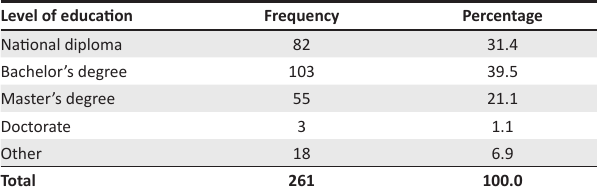
TABLE 6: The highest qualifications of the respondents.